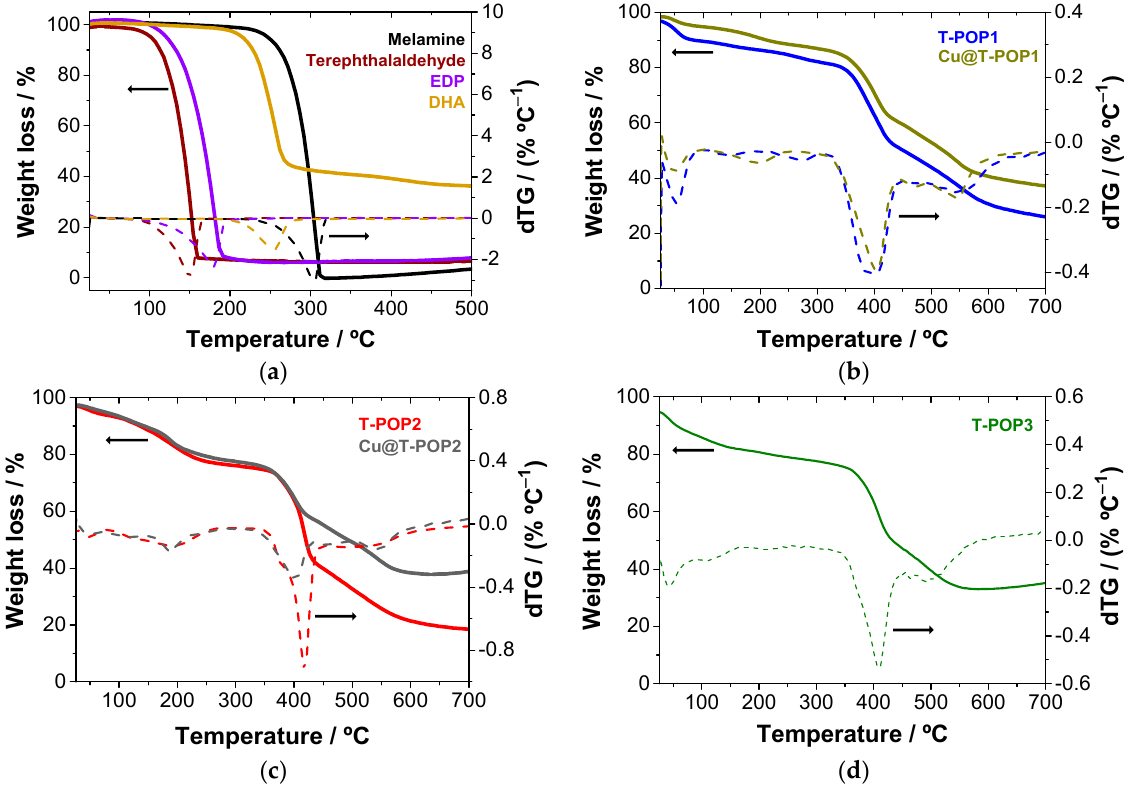
Figure 3. Thermograms (solid line) and dTGs (dotted line) of ( a ) melamine, terephthalaldehyde, 4-ethyl-2,6-diformylphenol (EDP), and 3,5-diformyl-4-hydroxybenzoic acid (DHA); ( b ) T-POP1 and Cu@T-POP1; ( c ) T-POP2 and Cu@T-POP2; and ( d ) T-POP3. The arrows indicate the corresponding ordinate axis.